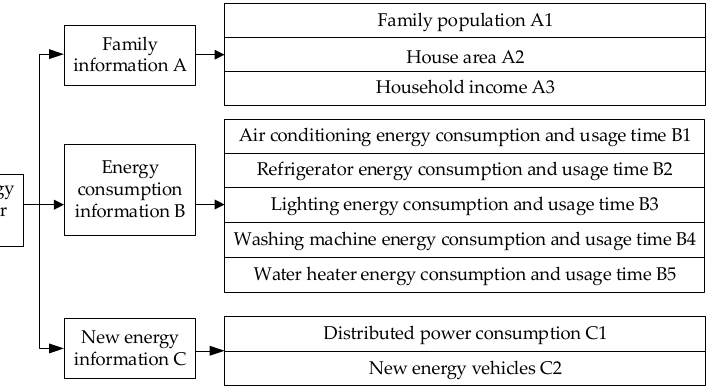
Figure 4. Resident user energy efficiency indicator system.